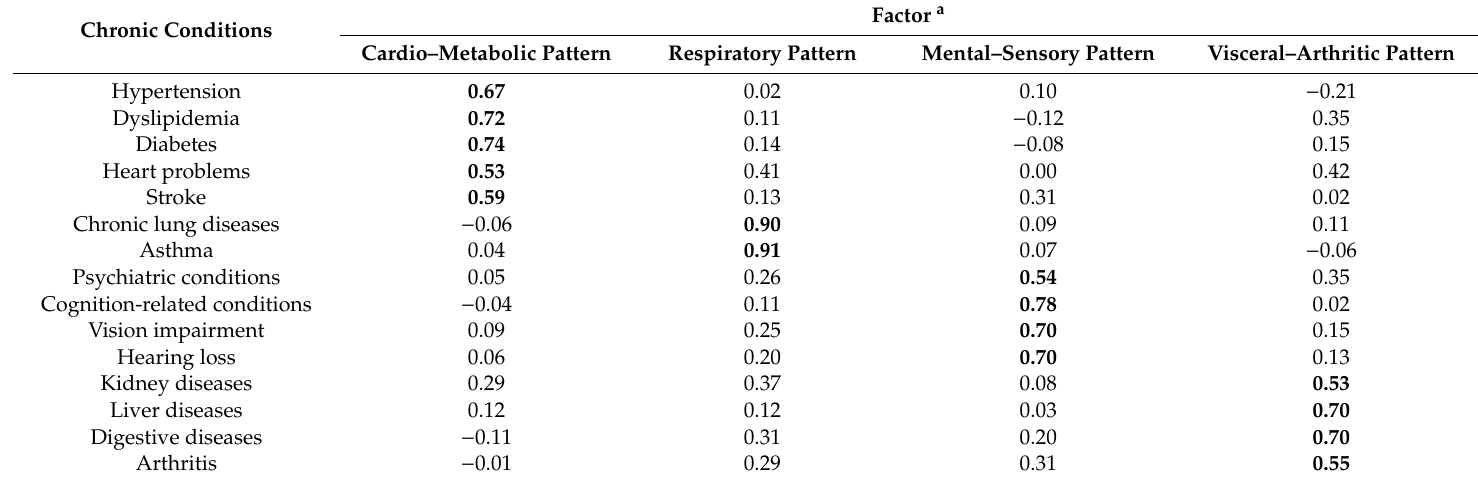
Table 2. Factor loadings of chronic conditions for the four multimorbidity patterns.